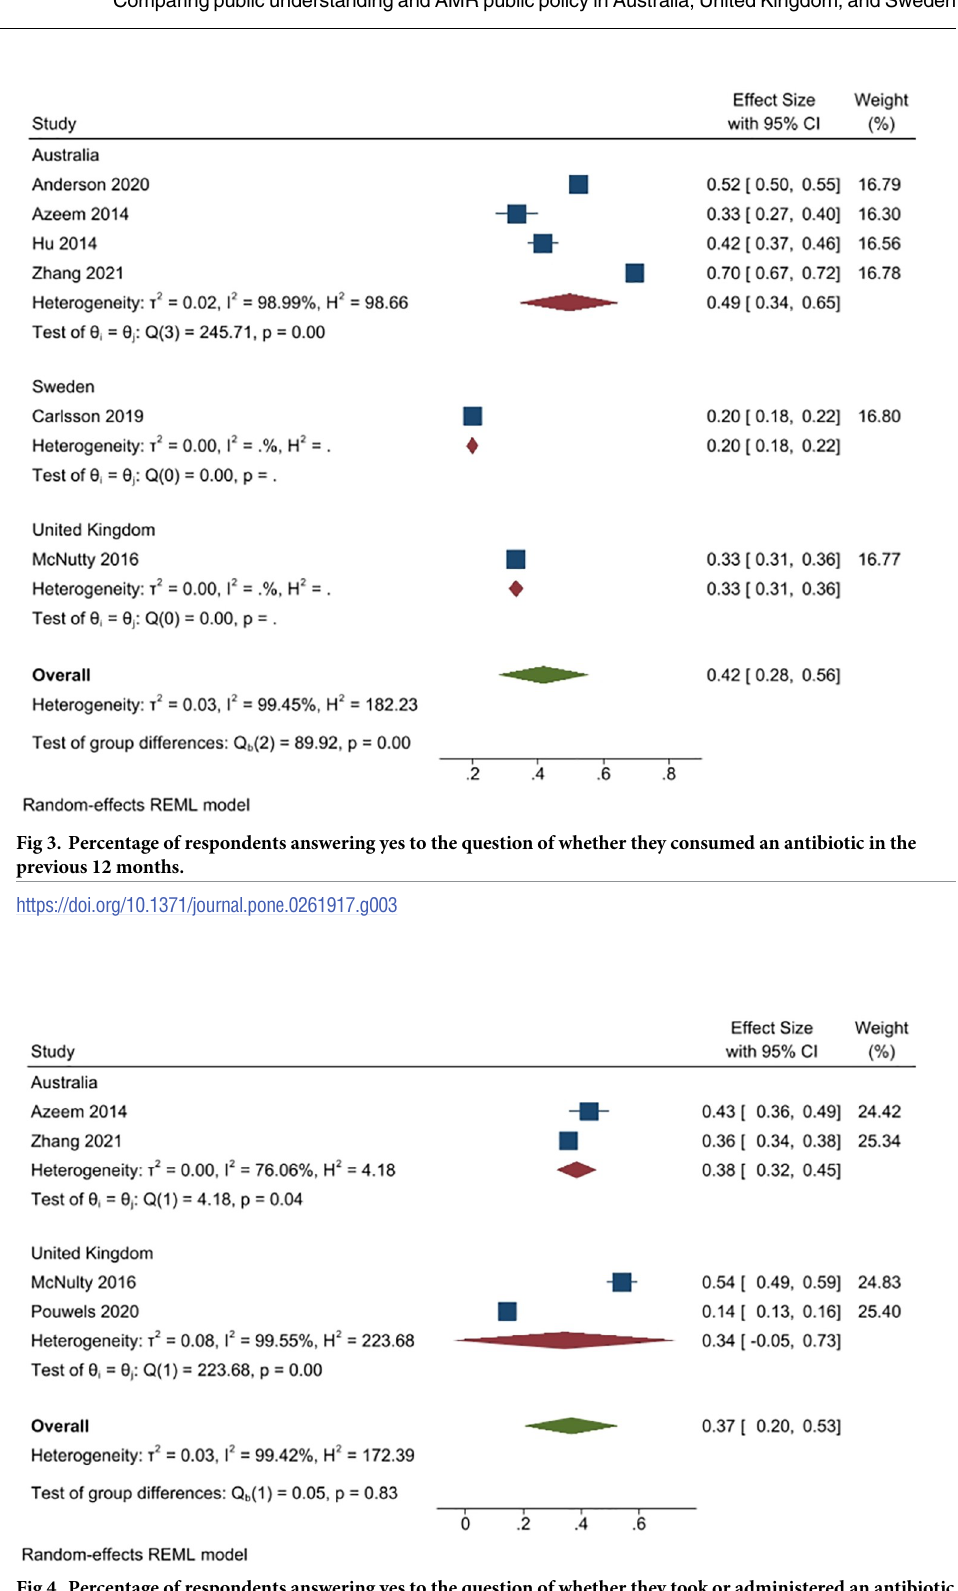
PLOS ONE | https://doi.org/10.1371/journal.pone.0261917 January 14,